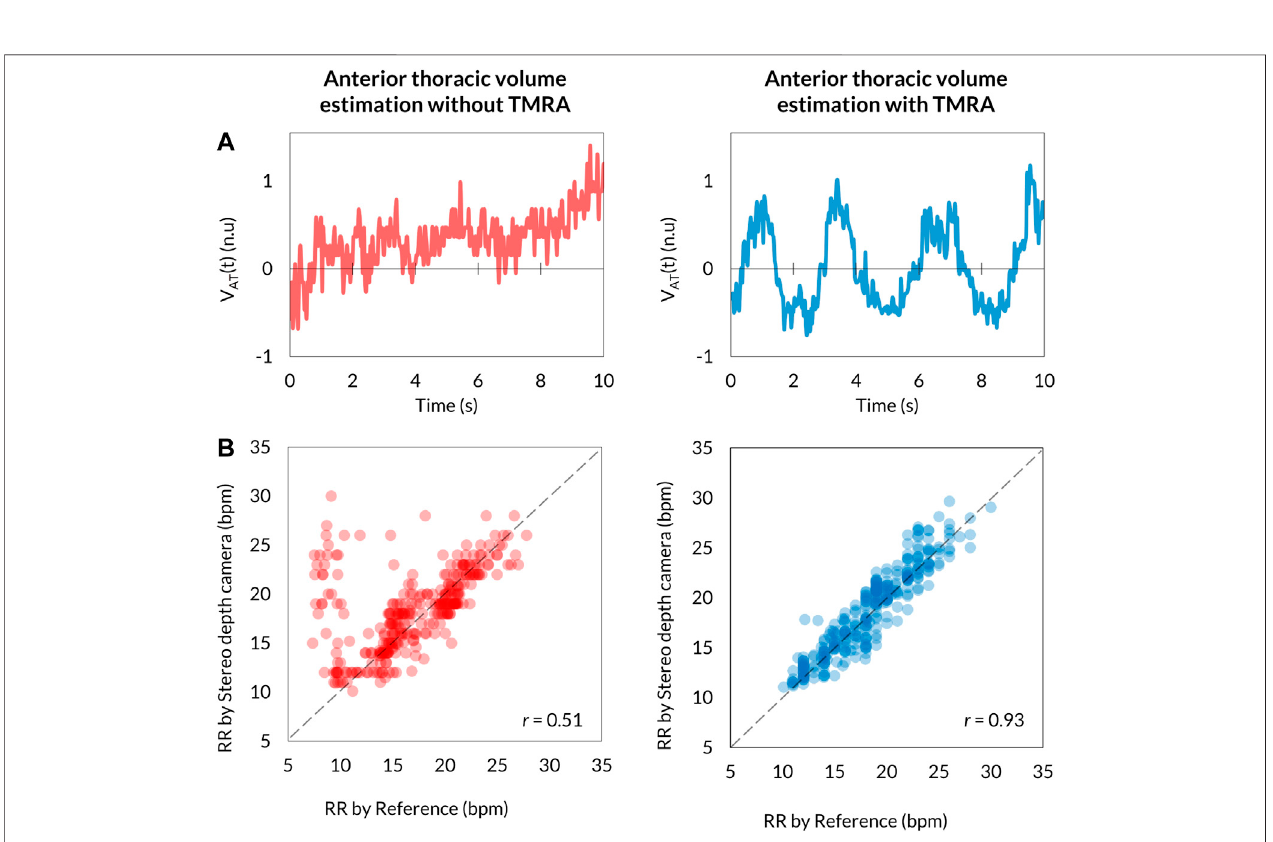
FIGURE 5 | Comparison of V AT ( t ) measurements between without (left) and with (right) TMRA. (A) Respiration signals (left; without TMRA, right; with TMRA). (B) Scatter plots of correlation between the Stereo depth camera-determined RR and the reference value (left; without TMRA, r = 0.51, right; with TMRA, r = 0.93).